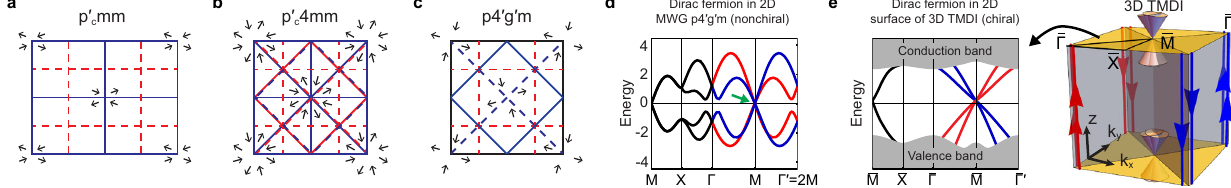
Fig. 1 MWGs and fourfold-degenerate Dirac fermions. a – c MWGs that protect fourfold degeneracy. Type-IV MWGs a p 0 and c Type-III MWG p 4 0 g 0 m . Black arrows represent spin con fi gurations located at generic positions. The styles of lines indicate the types of symmetry elements: glides (blue dashed lines), antiunitary glides (red dashed lines), mirrors (blue solid lines), and antiunitary mirrors (red solid lines). d Typical band structure of 2D crystals belonging to MWG p 4 0 g 0 m . Γ = (0, 0), X = ( π , 0), M = ( π , π ), and Γ 0 ¼ ð 2 π ; 2 π Þ denote high- symmetry points. A fourfold-degenerate Dirac fermion appears at M near E = 0 (green arrow). Red (blue) lines denote states with eigenvalue + i ( − i ) of the diagonal mirror. Along Γ - M - Γ 0 , each mirror eigenvalue sector of the Dirac fermion has a nonchiral dispersion. e Left: a Dirac fermion appearing as an anomalous surface state of a topological magnetic Dirac insulator (TMDI) with a chiral dispersion in each mirror sector. Right: schematic depiction of a TMDI, which hosts a fourfold-degenerate Dirac fermion on the (001) surface, and mirror-protected hinge modes on the sides invariant under diagonal